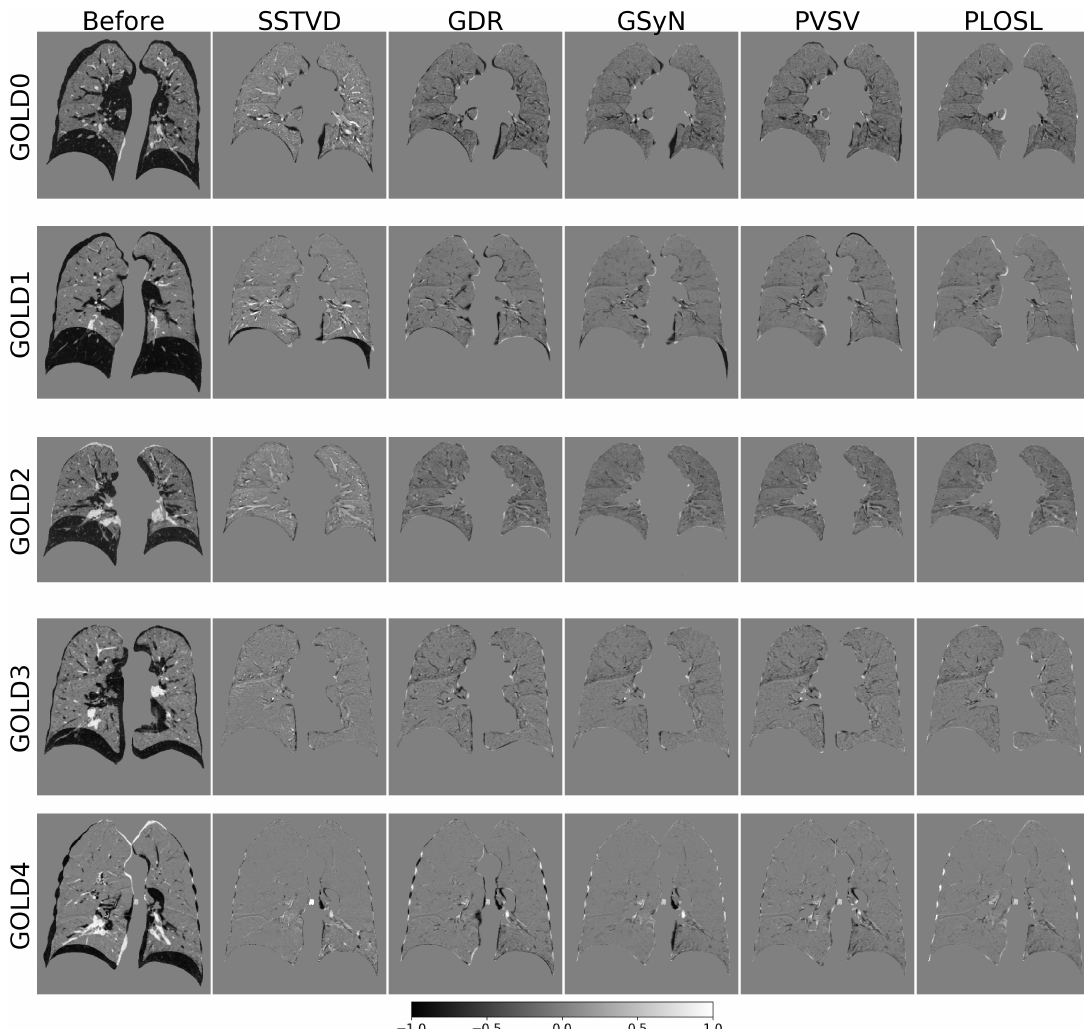
Figure A1. Difference images for the registrations used to compute the Jacobian determinant images shown in Figure 5. The first column shows a 2D coronal cross section of the lungs before registration. The last five images in each row show the same coronal cross section of the lungs that resulted from each registration algorithm. Gray corresponds to a zero difference. Black corresponds to negative values and white corresponds to positive values. A lung mask was used for registration and is the reason why the area outside the lungs is